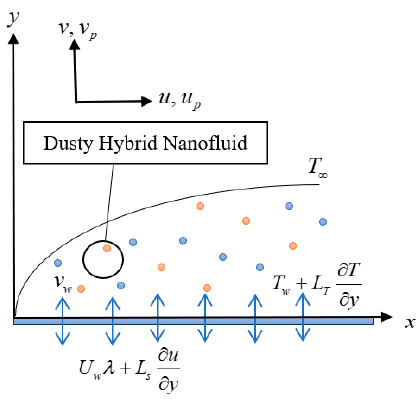
Figure 1. Physical model (stretching, λ > 0 and shrinking, λ < 0 ).